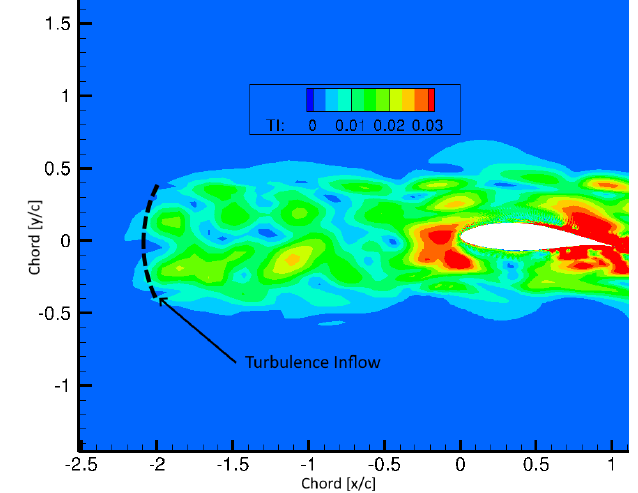
Figure 4. Instantaneous spatial distribution of turbulent fluctuations with an inflow TI of